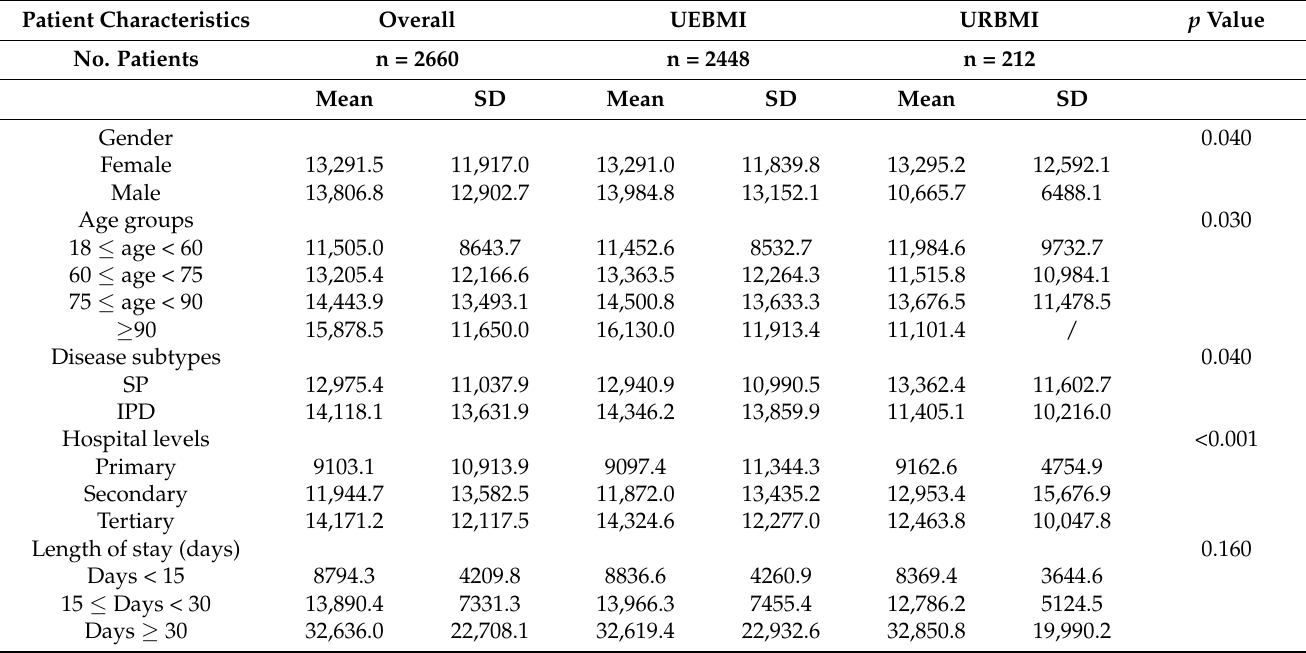
Table 6. Parkinson’s disease patient characteristics associated with inpatient